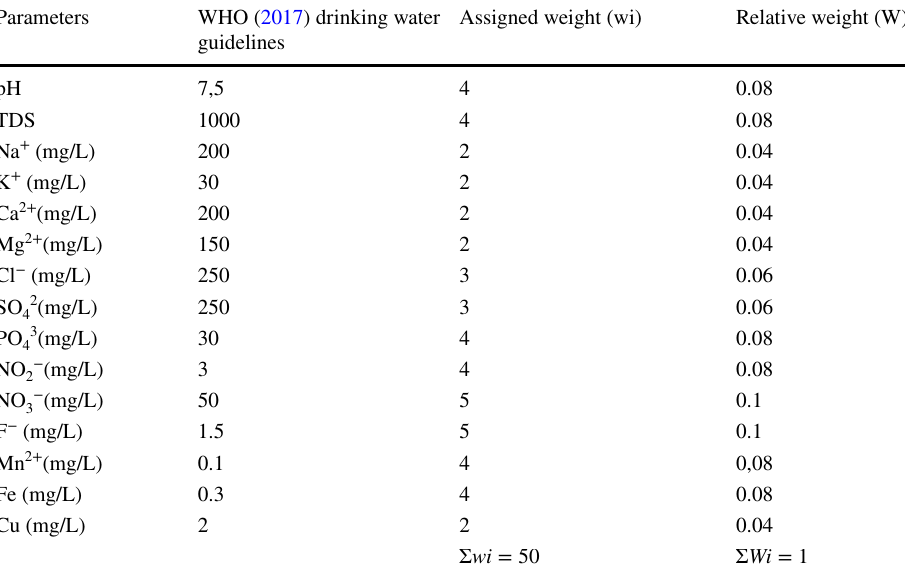
Table 5 WQI values based on the assigned weights and relative weights